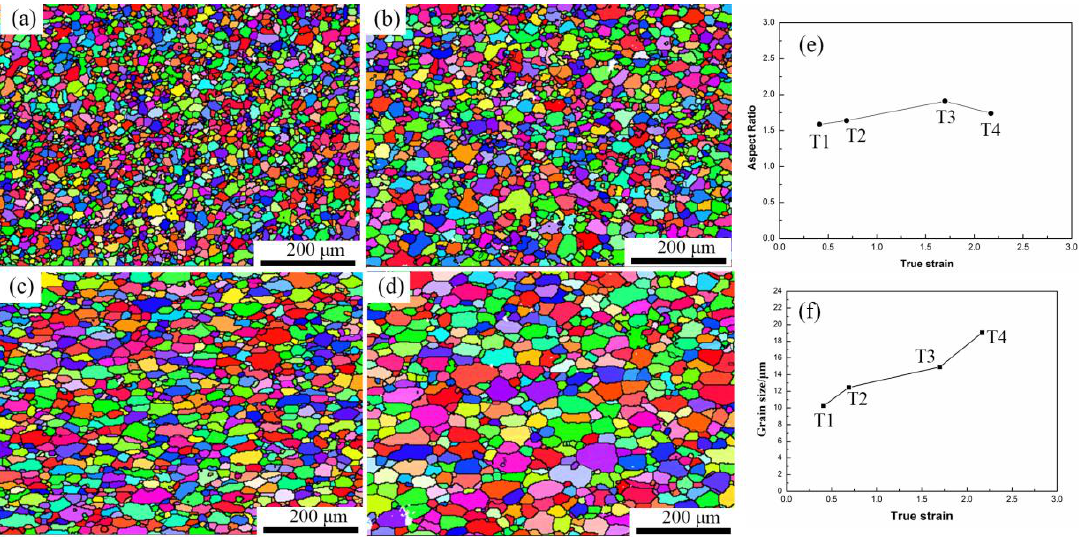
Figure 5. The evolution of grain morphology and size during superplastic deformation ( a ), ( b ), ( c ) and ( d ) respectively for the true strain with 0.41, 0.69, 1.61 and 2.17. ( e ) The variation of grain aspect ratio with strains and ( f ) the variation of grain size with strain.